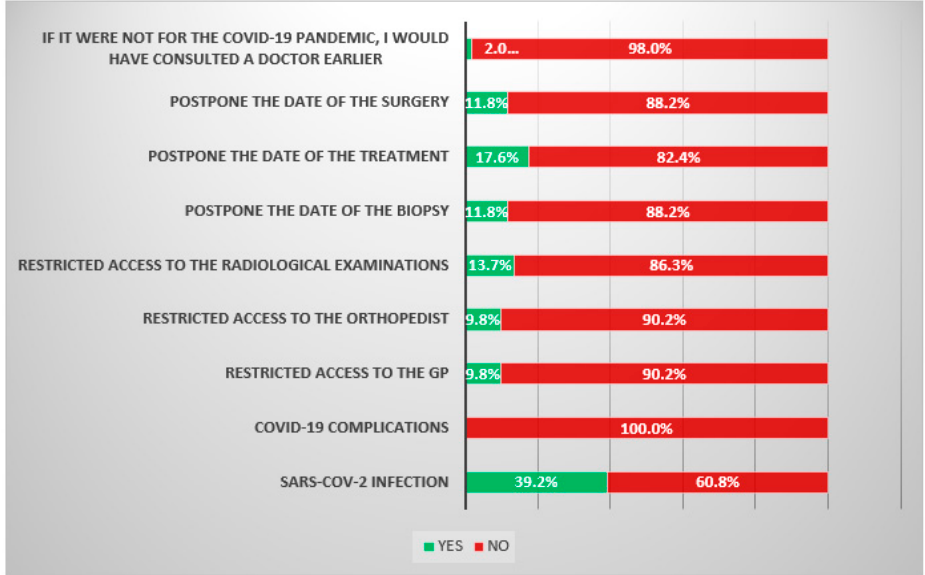
Figure 3. Survey results among patients treated during the COVID-19 pandemic. The survey consisted of 9 closed questions—Yes/No.